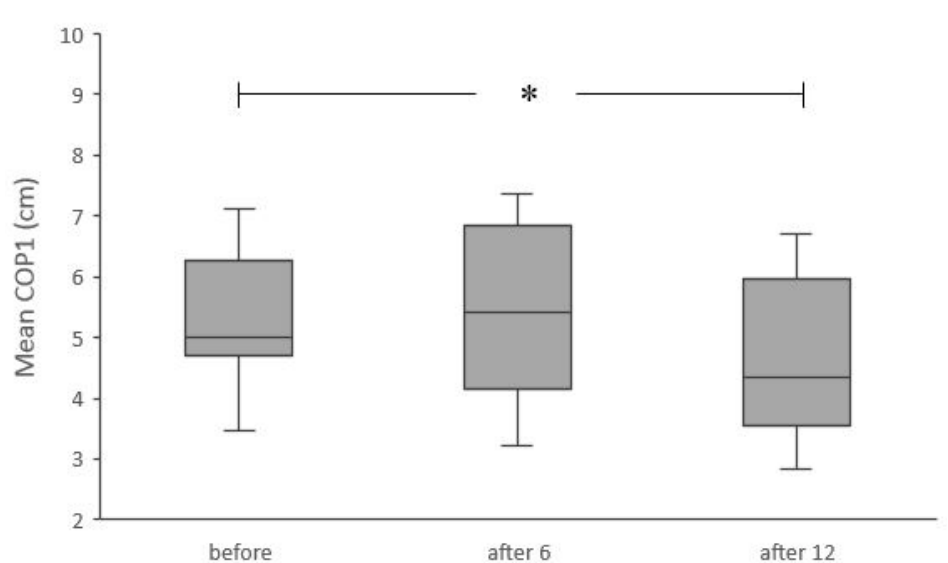
Figure 5. Results for the mean COP position relative to the medial malleolus in the first phase of limit of stability test, before intervention and after six and 12 training sessions. * Significant differences ( p < 0.05). Box plots indicate interquartile ranges (areas within a box), medians (horizontal line in the box), error bars indicate the range (min–max).